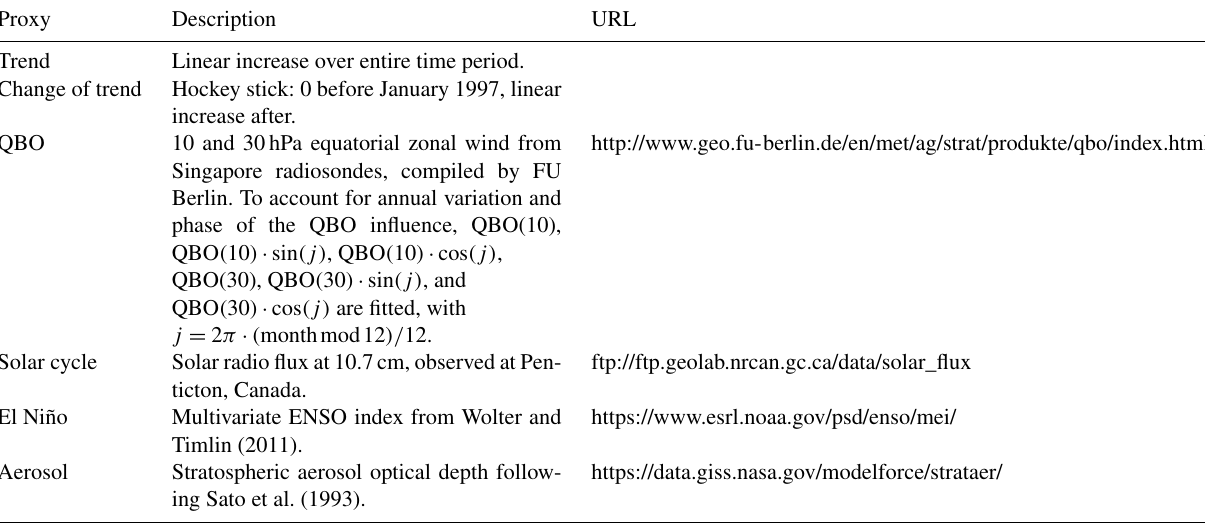
Table 4. Proxy time series used for the multiple linear regression in Eq. (2) in this study. Proxy Description URL Trend Linear increase over entire time period. Change of trend Hockey stick: 0 before January 1997, linear increase after. QBO 10 and 30hPa equatorial zonal wind from Singapore radiosondes, compiled by FU Berlin. To account for annual variation and